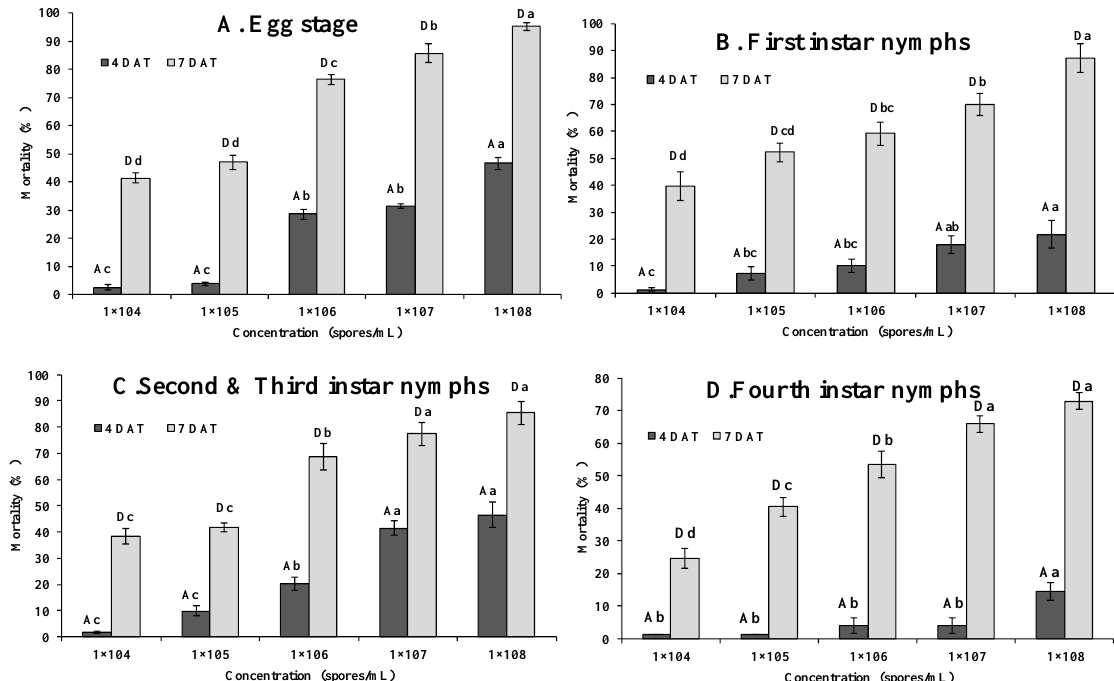
Figure 4. Mortality (% ± SE) of eggs ( A ), first instar nymphs ( B ), second and third instar nymphs ( C ), pupae ( D ) of A. rugioperculatus treated with fungus , Simplicillium lanosoniveum . Bars with different uppercase letters on the top of error bars indicate significant differences among the different days after treatment and with different lowercase letters indicate significant differences for different treatments i.e., concentration of fungus , Simplicillium lanosoniveum . ( p < 0.05, Tukey ’ s test).